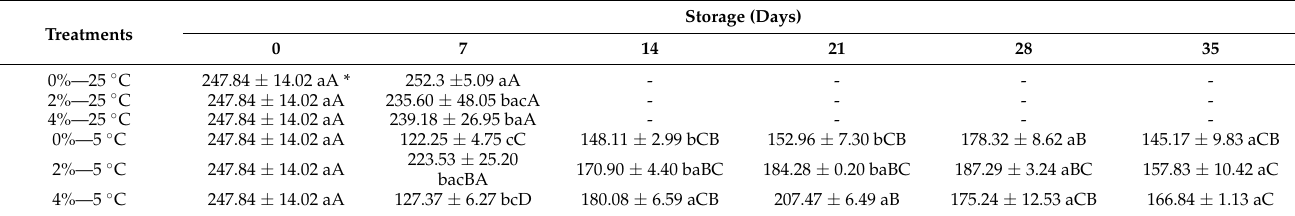
Table 3. Respiratory rate (mg CO 2 kg − 1 h − 1 ) of plums with different concentrations of edible coating stored for up to 7 days at 25 ◦ C and 35 days at 5 ◦